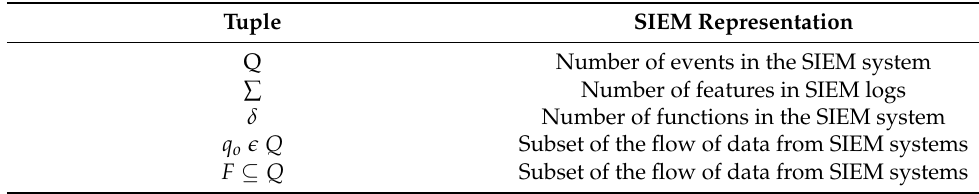
Table 3. Mapping FSM with anomaly detection